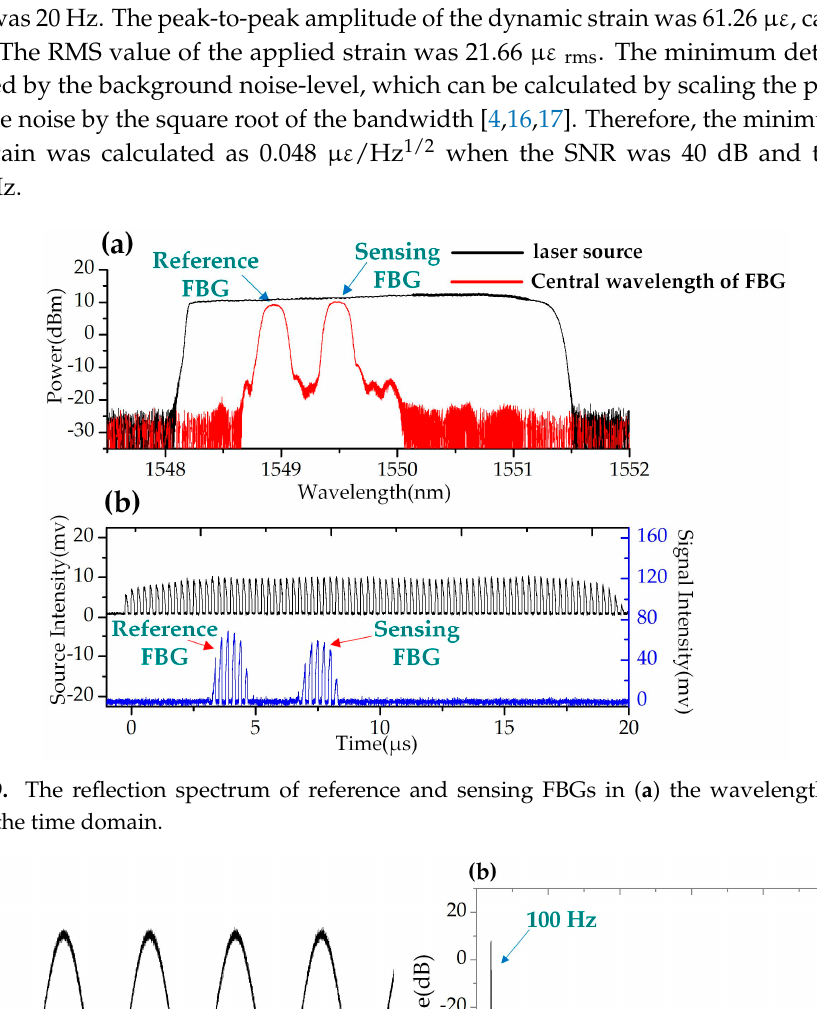
Figure 9. The reflection spectrum of reference and sensing FBGs in ( a ) the wavelength domain and ( b ) the time domain.